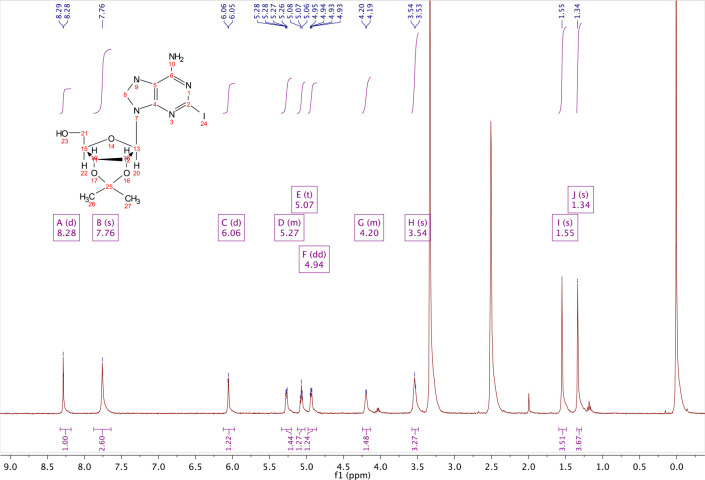
1H NMR of compound 1.